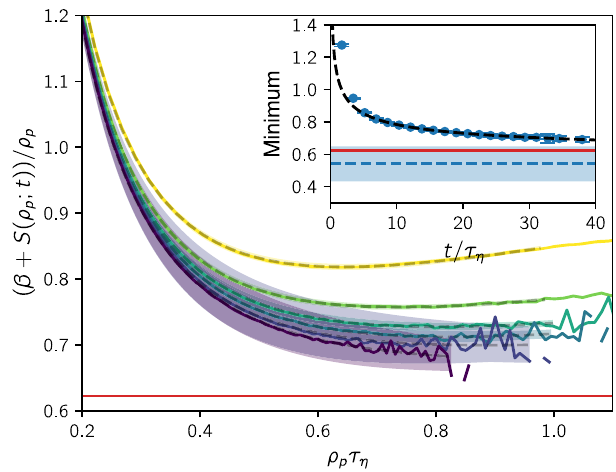
Fig. 5 Determination of the steepest-descent minimum. The Cramér function is estimated from FTLE histograms by (12). We call these fi nite- time estimates S ( ρ p ; t ). Here we show the function minimized in (15) for estimates of the Cramér function ranging from t = 6.90 τ η (yellow) up to t = 39.68 τ η (violet). Best fi ts are indicated by dashed lines with shaded areas showing their error (see Methods for details). Inset: Minima of these functions over time. A simple fi t of the decay of minima (black dashed line) yields an estimate of their limiting value α = 0.54 ± 0.11 (horizontal blue dashed line and shaded area). For comparison, the red lines show the value of α estimated by subtracting 2 from the observed curvature PDF power- law exponent in Fig. 2b, showing a good agreement within uncertainties. For more details, see prediction for the curvature PDF f ð κ Þ (cid:3) κ (cid:2) 2 (cid:2) α : ð 16 Þ